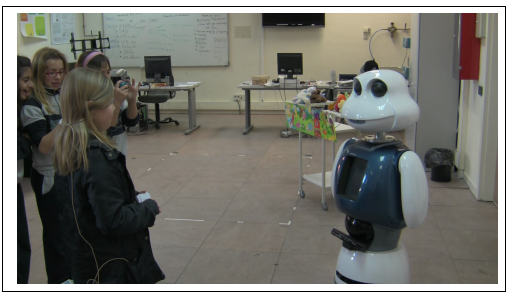
Figure 2. Interaction with children aged from 8 to 10.